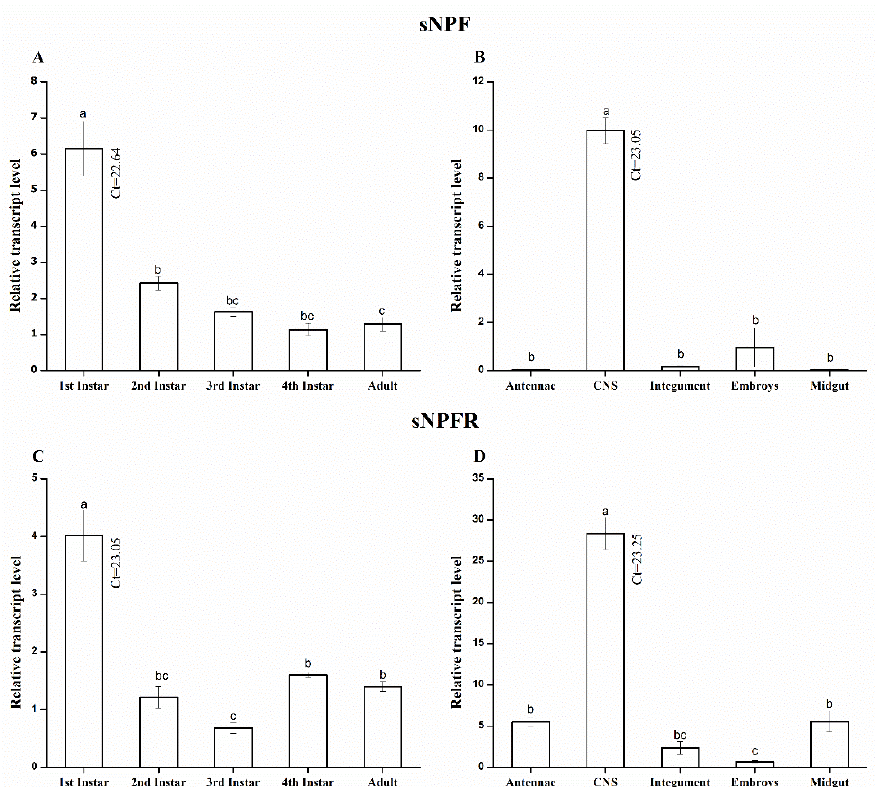
Figure 4. Analysis of relative expression levels of A. pisum sNPF and sNPFR transcripts measured by qRT ‐ PCR. Development expression profile of ApsNPF and ApsNPFR ( A , C ) and spatial expression profiles of ApsNPF and ApsNPFR ( B , D ). Acronyms used on X ‐ axis: CNS (central nervous system), Ct (cycle threshold). The bars correspond to the average of three independent replicates. Results are shown as means ± S.E. Different lowercase letters above each bar indicate significant differences among different treatments using one ‐ way ANOVA followed by LSD ( p < 0.05).